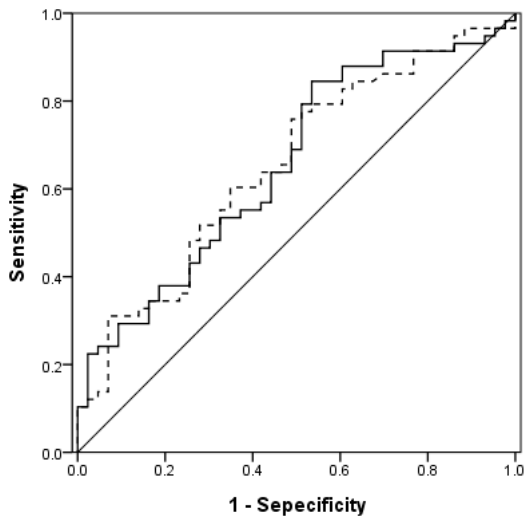
Figure 2. Receiver-operative characteristics (ROC) curves of SpO 2 /FiO 2 (continuous line) and PaO 2 /FiO 2 (dotted line) for mortality prediction.